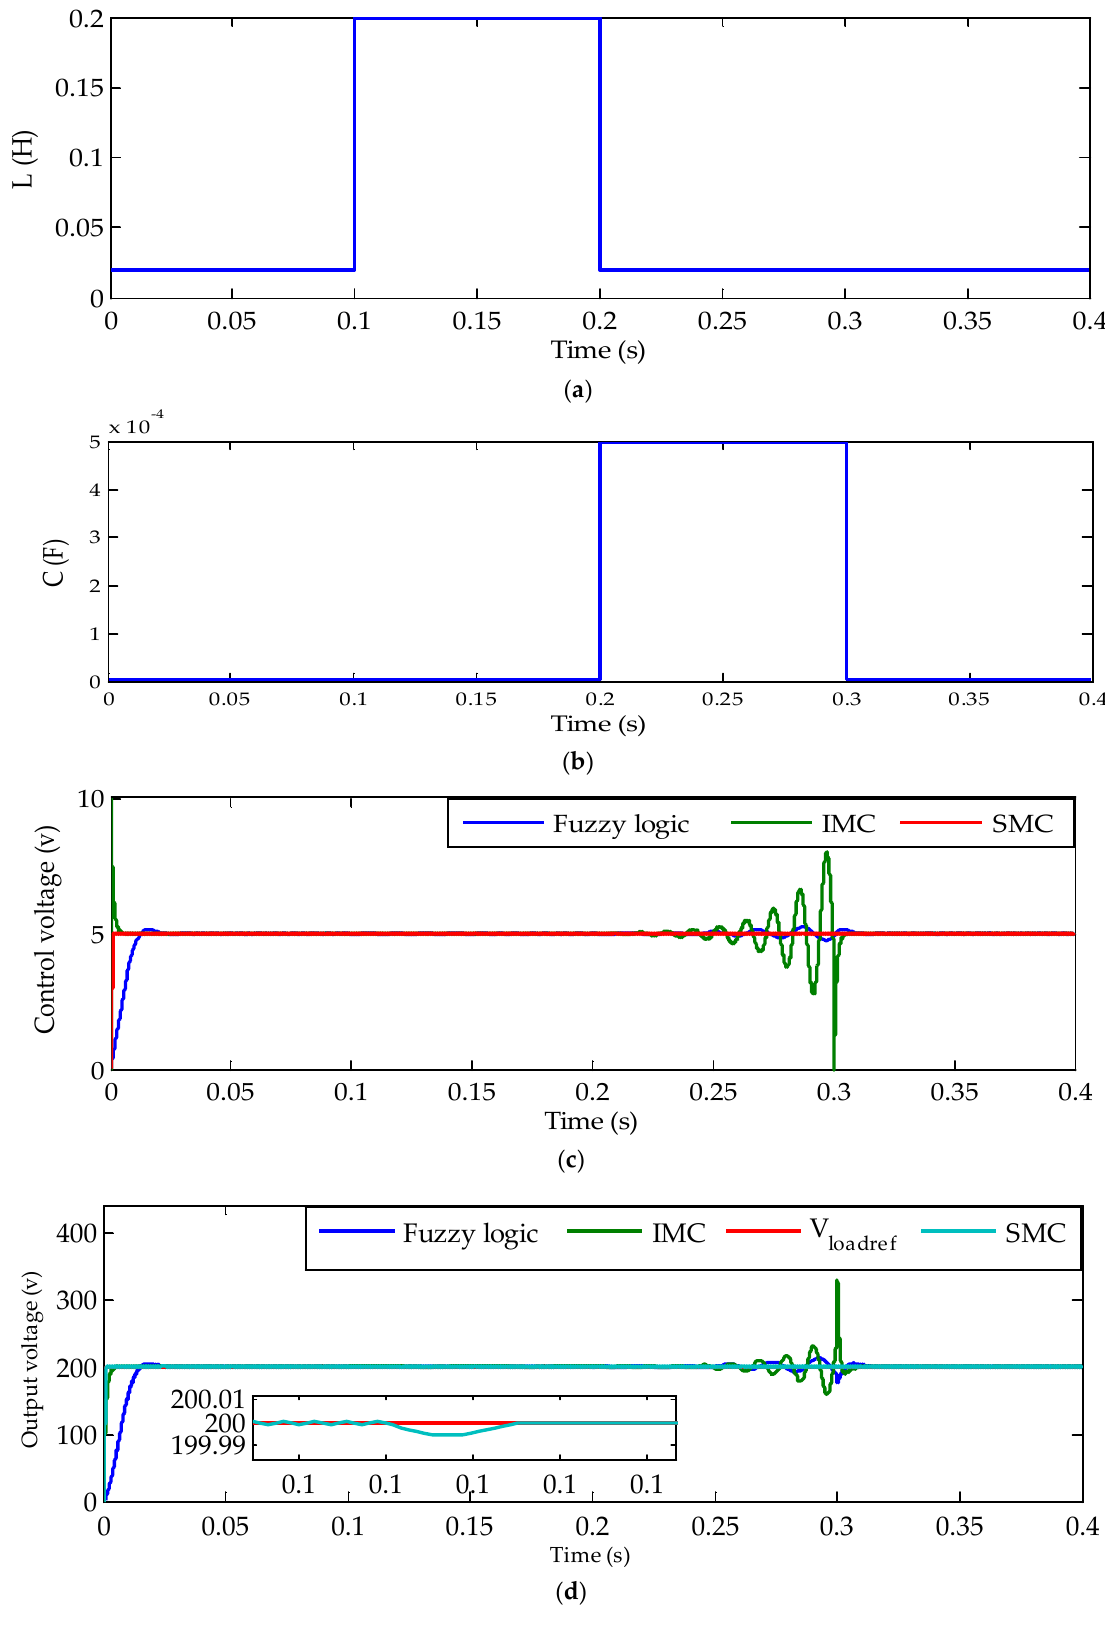
Figure 12. DC-DC buck converter parameters variations: ( a ) trajectory of the inductor, ( b ) trajectory of capacitor, ( c ) control voltage and ( d ) output voltage.